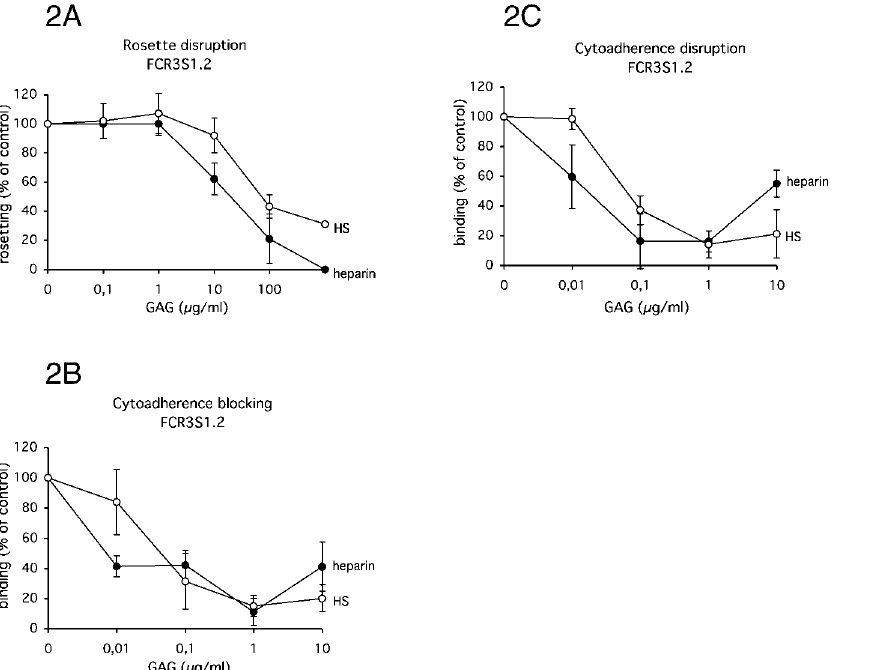
Figure 2. Effect of Heparin and HS on P. falciparum Rosettes and Cytoadherence of IE In Vitro (A) Aliquots of rosetting parasite cultures (FCR3S1.2) were treated with heparin or HS at different concentrations. The rosetting-rates were counted after 30 min incubation and compared with mock treated samples. The cytoadherence assays (B and C) with IE (FCR3S1.2) and heparin or HS were performed under orbital shaking (50 rpm) at 37 8 C. Increasing concentrations of heparin and HS were added together with IE (B) or after letting the IE adhere (C). Unbound material was removed before the slides were fixed in glutaraldehyde, stained with Giemsa and analyzed by light microscopy at a x1,000 magnification. DOI: